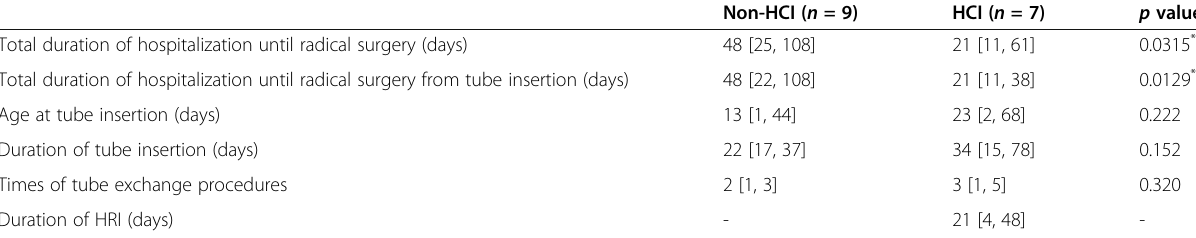
Non-HCI ( n = 9) HCI ( n = 7)